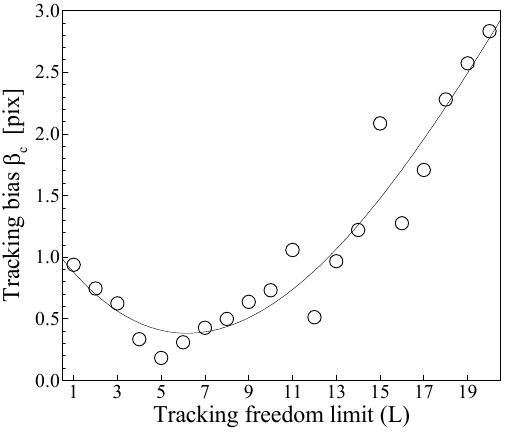
Figure 9. Tracking bias distribution on the freedom limit for termite head-banging case at the 225 th frame.